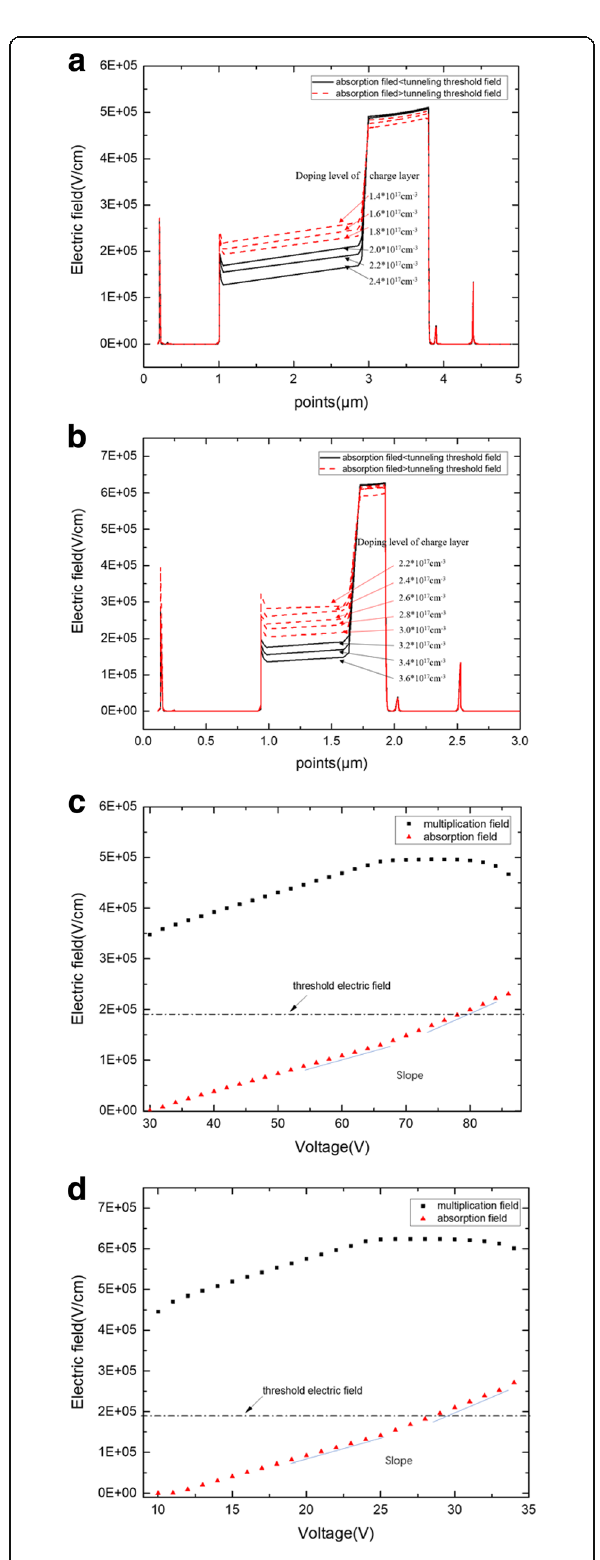
Fig. 12 a Avalanche breakdown electric field with different doping levels (APD-1). Thickness of charge layer is 90 nm. Red dashed lines: the field of absorption is larger than the tunneling threshold field. Black solid lines: the field of absorption is less than the tunneling threshold field. a Presents the simulation results of electric field distribution with different doping level while avalanche breakdown. When doping level of charge layer exceeds 2.0 × 10 17 cm − 3 , the field in the absorption layer becomes lower than the tunneling threshold field, and the avalanche field in the multiplication layer reaches the same value with different doping level. However, when the doping level is less than 2.0 × 10 17 cm − 3 , the field in the absorption layer exceeds the tunneling threshold field, and the avalanche field in the multiplication layer decreases with the decrease of the doping level. Thus, if the electric field in the absorption layer exceeds the tunneling threshold value at or over the breakdown voltage, then the breakdown electric field in the multiplication will decrease. Thus, the electric field in the absorption should be less than the tunneling threshold value to maintain the high field in the multiplication layer when the device avalanche breaks down. b Avalanche breakdown electric field with different doping levels (APD-2). Thickness of charge layer is 90 nm. Red dashed lines: the field of absorption is larger than the tunneling threshold field. Black solid lines: the field of absorption is less than the tunneling threshold field. The figure description of b is similar to a . c Relationship between field and bias voltage in multiplication and absorption (APD-1). Thickness of charge layer is 90 nm. Electric field of multiplication (black square). Electric field of absorption (red triangle). c Presents the relationship between the electric field and bias voltage in multiplication and absorption layers. When the electric field in the absorption layer reaches the tunneling threshold value, the avalanche breakdown electric field in the multiplication gradually decreases. Moreover, the absorption field slope increases when the electric field in the absorption layer exceeds the tunneling threshold. d Relationship between field and bias voltage in multiplication and absorption (APD-2). Thickness of charge layer is 90 nm. Electric field of multiplication (black square). Electric field of absorption (red triangle). The figure legend of d is similar to